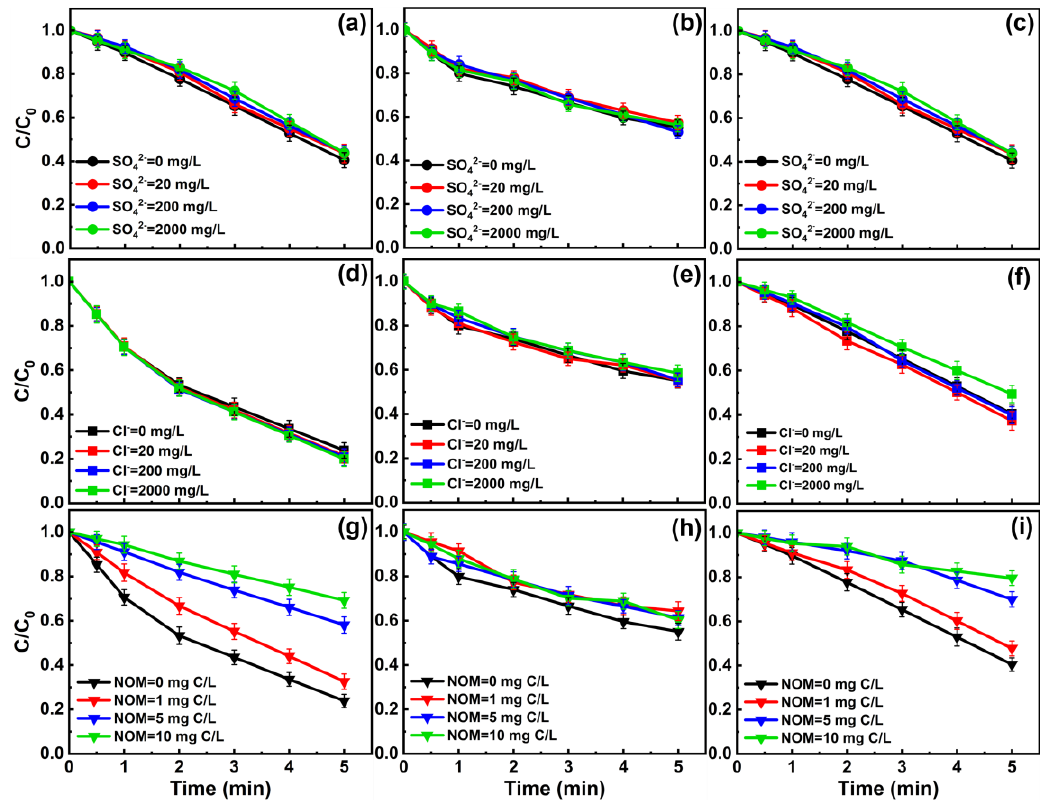
Figure 4. Effect of coexisting SO 42 − , Cl − , and NOM on the degradation of ( a , d , g ) RB5, ( b , e , h ) ANL, and ( c , f , i ) PVA in the MPUV/PAA system. Conditions: [PAA] 0 = 15 mg/L, [Contaminant] 0 = 10 mg/L, pH= 7.5, T = 25 ± 1 °C, UV exposure time = 5 min.